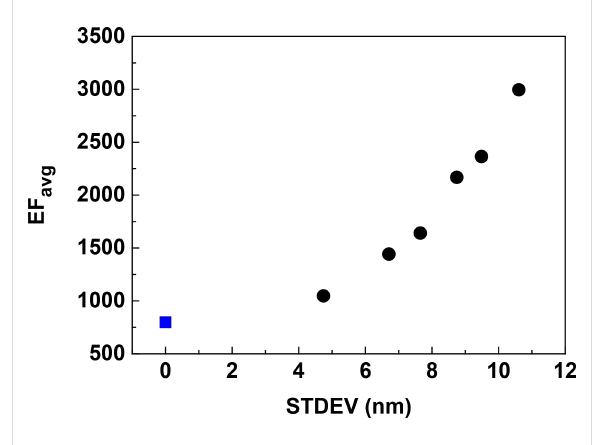
Figure 11: The dependence of EF avg on the standard deviation of the gap size along the y -direction in the S42 AgNR 2D random array with AR = 3.5. The average gap size is 21 nm in the y -direction. The excita- tion wavelength is 632.8 nm and the polarization is parallel to the y -direction. The blue square in the figure indicates the ordered one with the gap size of 21 nm in the y